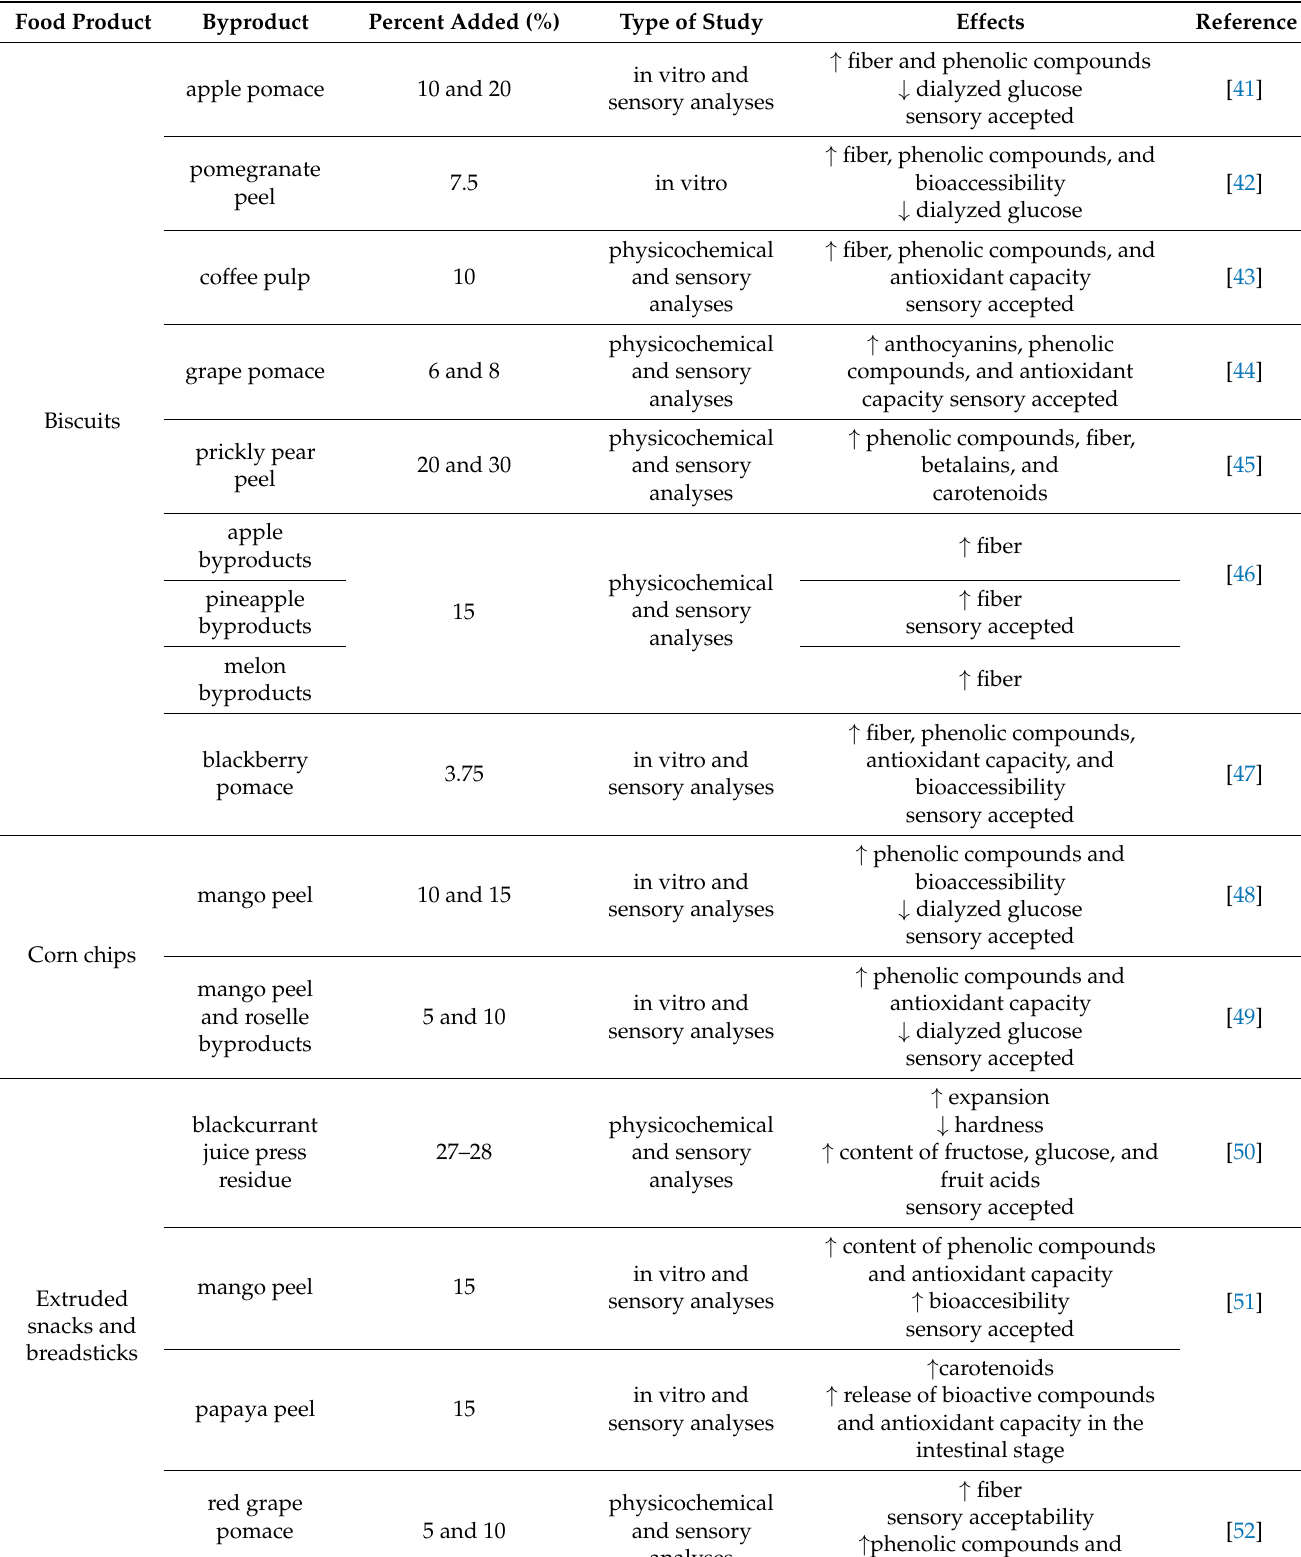
Table 1. Summary of baked food products supplemented with agro-industrial byproducts and main findings related to the